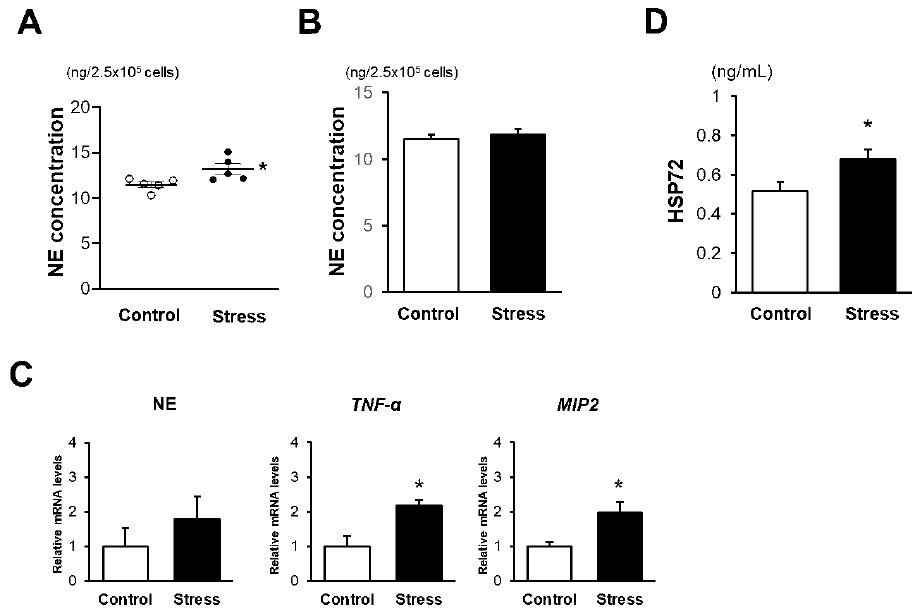
Figure 5. Priming of neutrophils and subsequent NE release upon stimulation are augmented in stressed mice. ( A ) NE concentration in supernatants of BM neutrophils after stimulation with formyl peptide receptor (FPR) 1-specific peptide agonist. Values represent the mean ± SEM. Each group consisted of five (Control) and five (Stress) samples. * p < 0.05 vs. Control. ( B ) NE concentration in lysates of bone marrow (BM) neutrophils before stimulation with FPR 1-specific peptide agonist. Values represent the mean ± SEM. Each group consisted of five (Control) and five (Stress) samples. ( C ) Quantitative PCR analysis of NE, TNF- α, and MIP2 mRNA expression levels in peripheral blood neutrophils. Values represent the mean ± SEM relative to Control. Each group consisted of 4–5 (Control) and 4–5 (Stress) samples. * p < 0.05 vs. Control. ( D ) Serum concentration of HSP-72 before HFD feeding. Values represent the mean ± SEM. Each group consisted of five (Control) and five (Stress) samples. * p < 0.05 vs. Control. Control, unstressed control mice; Stress, stressed